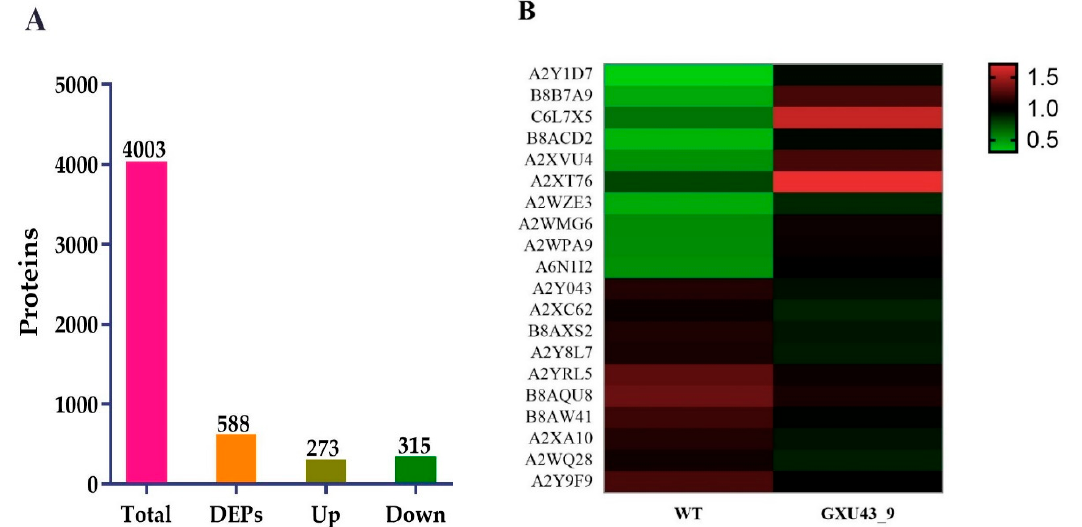
Figure 5. Proteomic analysis information of the CRISPR mutant GXU43_9 and its WT. ( A ) Upregulated and downregulated differentially expressed proteins (DEPs), and ( B ) Heatmap of the top twenty DEPs. Red color denotes the higher while the green color represents a lower level of expression. Table 3. Differentially expressed proteins related to GA and plant growth.